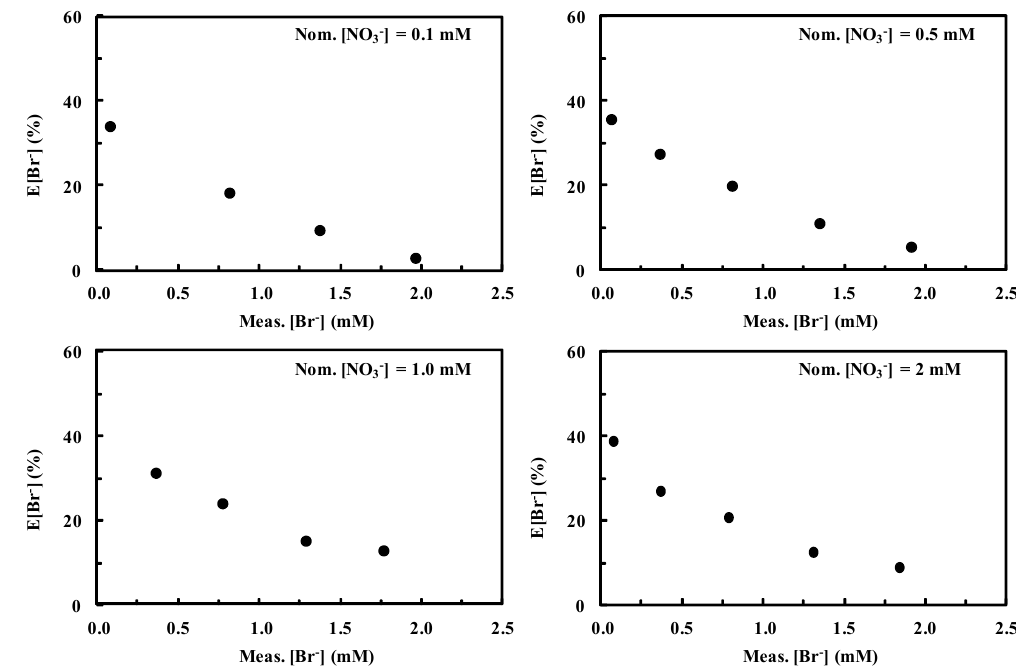
Figure 2. Dependence of E[Br − ], defined according to Equation 1, on measured [Br − ] (Meas.[Br − ]) at fixed nitrate concentration. Eluent 1 mM NaHCO 3 –3.2 mM Na 2 CO 3 . Figures were obtained by integrating the peaks according to Figure 1.